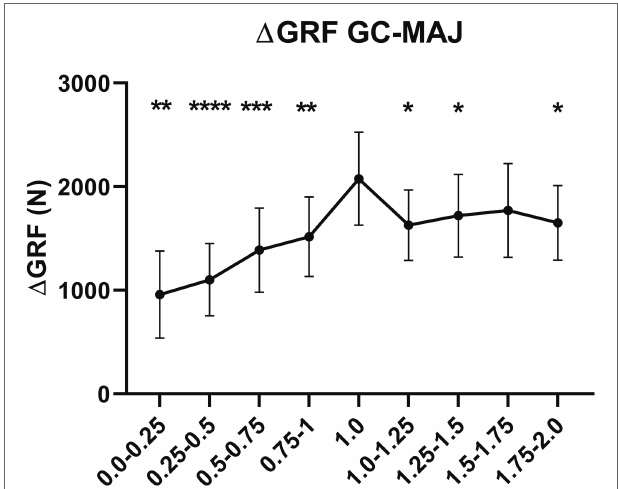
FIGURE 5 | Delta difference in peak Z GRF between ground contact (GC) and MAJ in all the hypo-gravity levels (0–0.25 g, 0.25–0.5 g, 0.5–0.75 g, and 0.75–1 g), hyper-gravity levels (1–1.25 g, 1.25–1.5 g, 1.5–1.75 g, and 1.75– 2 g), and 1 g. Results shown as mean ± SD of three jumps per gravity level per subject. * p < 0.05 vs. 1 g; ** p < 0.01 vs. 1 g; *** p < 0.001 vs. 1 g; **** p < 0.0001 vs. 1